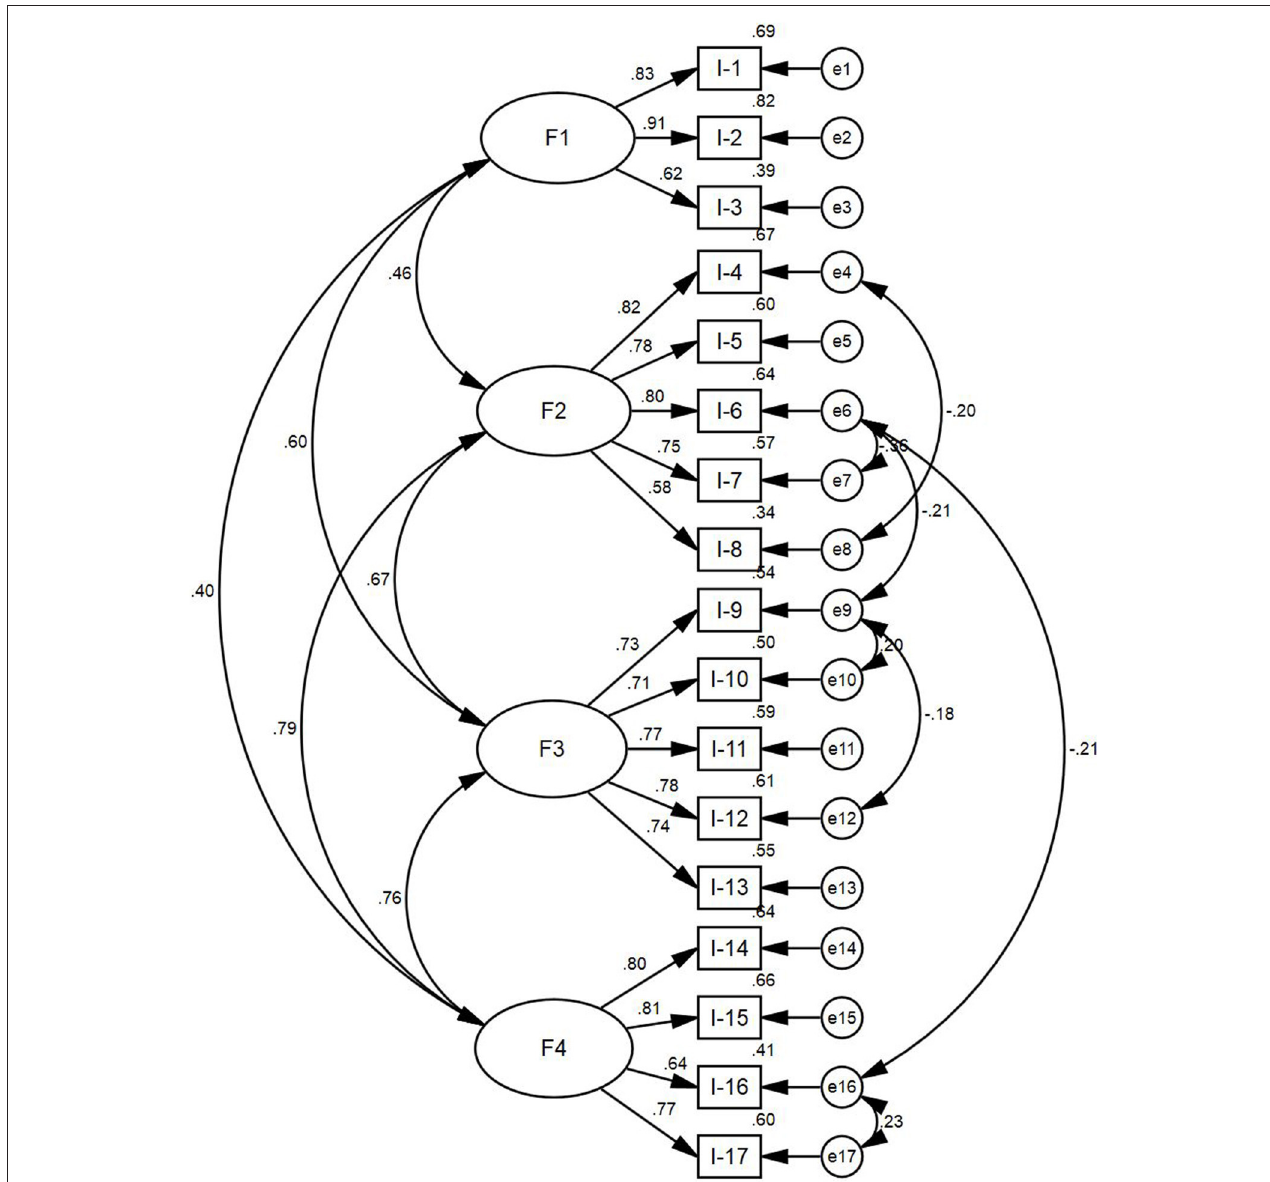
FIGURE 3 | Standard path and parameter estimation of confirmatory factor analysis. F1, Factor 1, mild respiratory system diseases; F2, Factor 2, severe respiratory system diseases; F3, Factor 3, respiratory system symptoms; F4, Factor 4, treatment and recovery of respiratory system diseases.